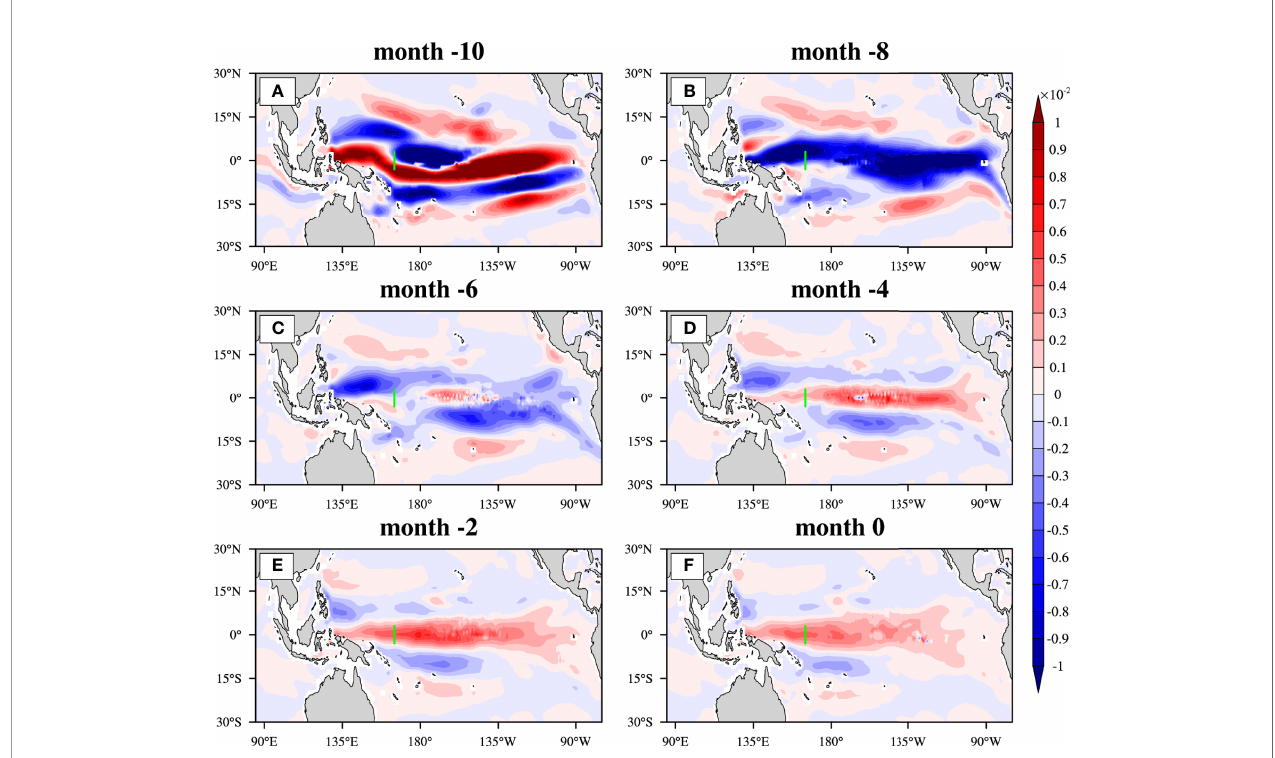
FIGURE 6 | Evolution of the zonal velocity anomalies (m s – 1 ) averaged between s q = 23.0 and 26.2 from previous 10 months to the target month (marked as A – F , respectively) due to the sensitivity-like wind velocity perturbation at month – 11. The zonal velocity anomaly is de fi ned as the bias between the unperturbed state and the perturbed state caused by the sensitive wind. The target section is marked with a green line.